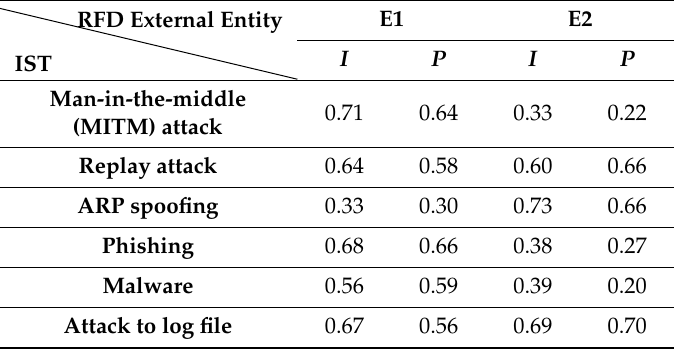
Table 2. The IST evaluation scores for DFD External Entity of the ELB practice.